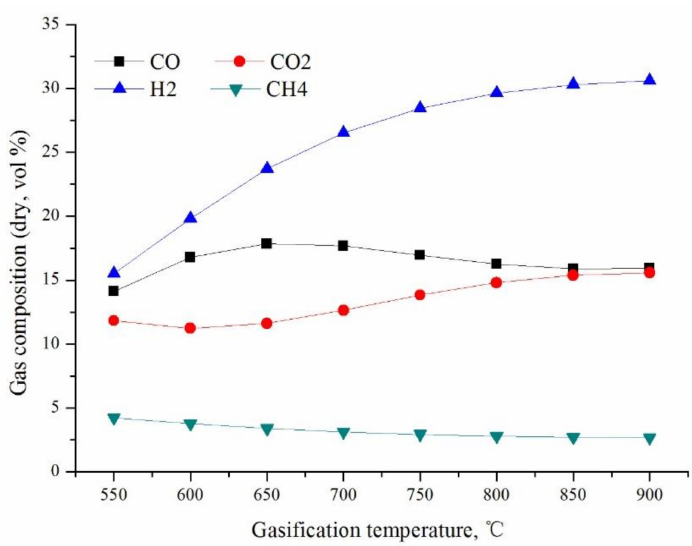
Figure 7. E ff ect of gasification temperature on syngas composition (Simulation, ER = 0.2, S / C =